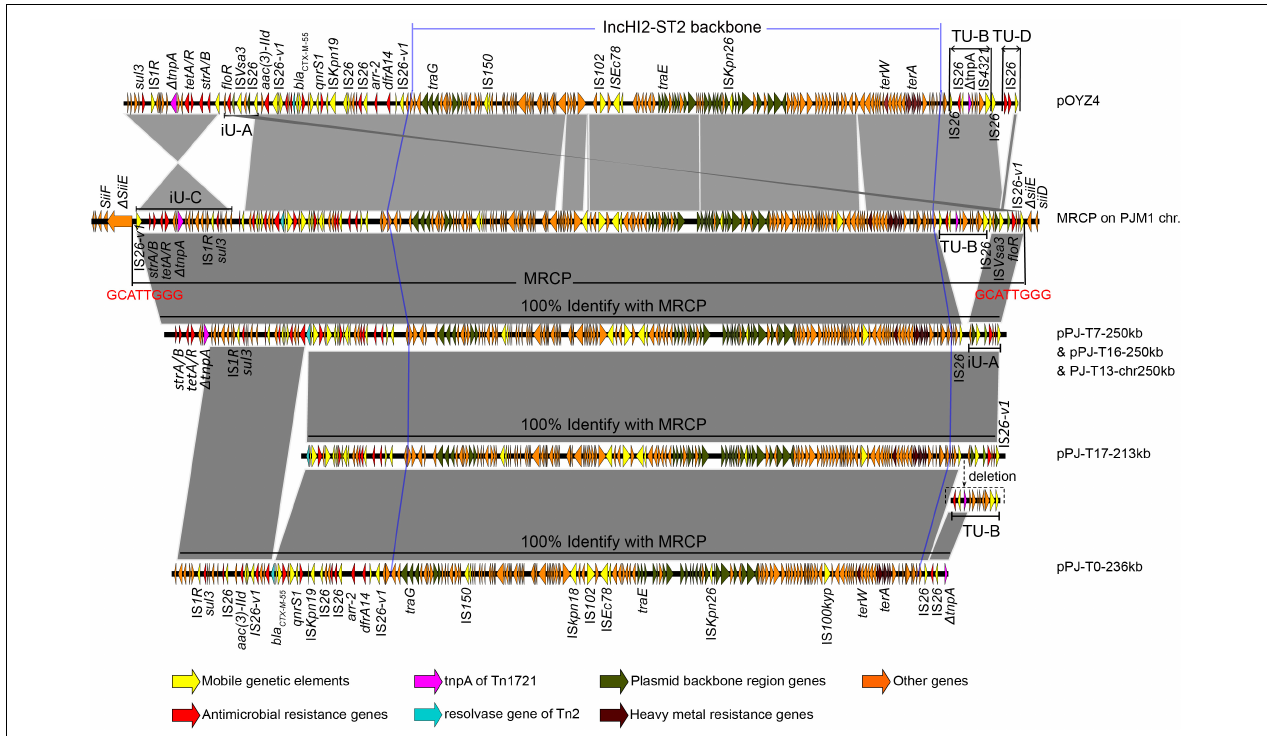
FIGURE 3 | Sequence alignment of the multidrug-resistant chromosomally integrated plasmid (MRCP), its progeny, and pOYZ4. The highlighted GCATTGGG nucleotides represent the duplicated DRs that flanked MRCP. Regions of > 99% identity are marked by gray shading. The positions of the genetic structures iU-A, TU-B, iU-C, and TU-D were marked. iU, inversion unit; TU, translocatable